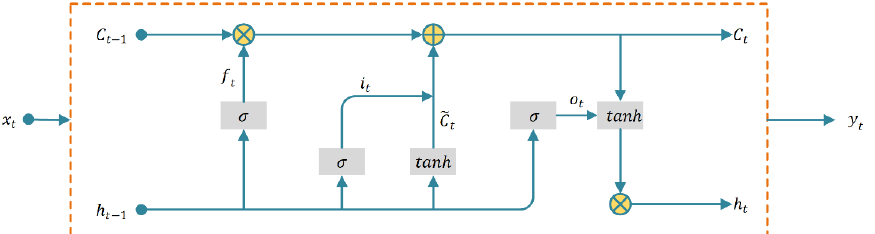
Figure 2. The basic structure of an LSTM cell. The blue arrows indicate the direction of data flow. The grey rectangles indicate activation functions. The yellow symbols represent the calculation process of data.